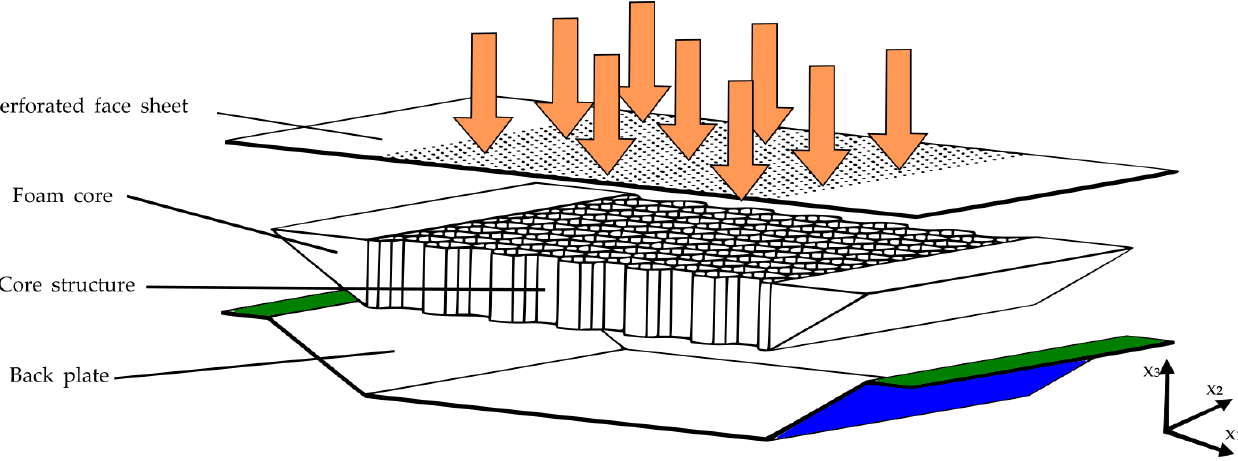
Figure 10. Fixed boundary condition (green), adhesive bonding (blue), applied forces